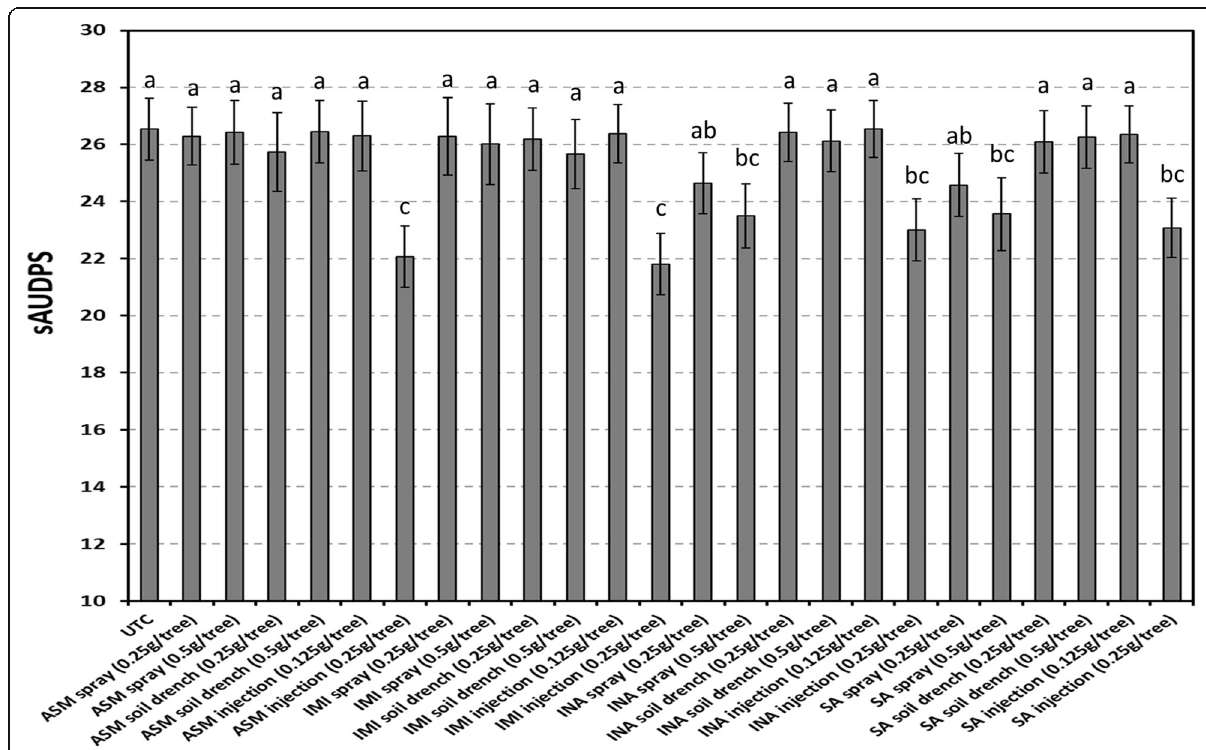
Fig. 2 HLB disease severity, expressed as standardized area under the disease progress stairs (sAUDPS), achieved by various SAR inducer treatments at the end of a three-year field trial (2015 – 2018). Bars represent standard deviations of the mean ( n = 6). Different letters on the bars indicate significant difference among the treatments based on Tukey ’ s HSD test ( α =